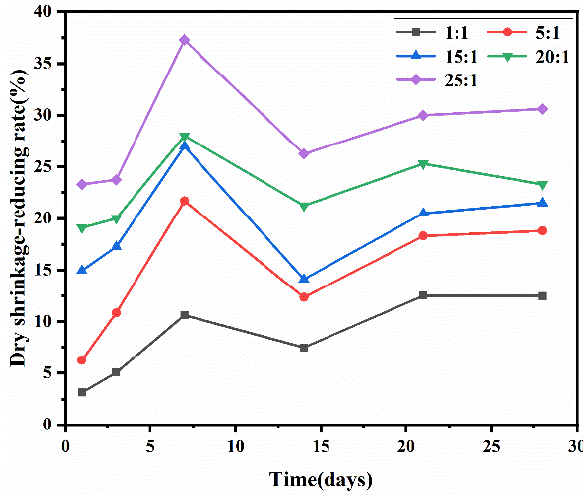
Figure 8. Dry shrinkage-reducing rates of cement mortars containing PBA-g-PDMAEMA.